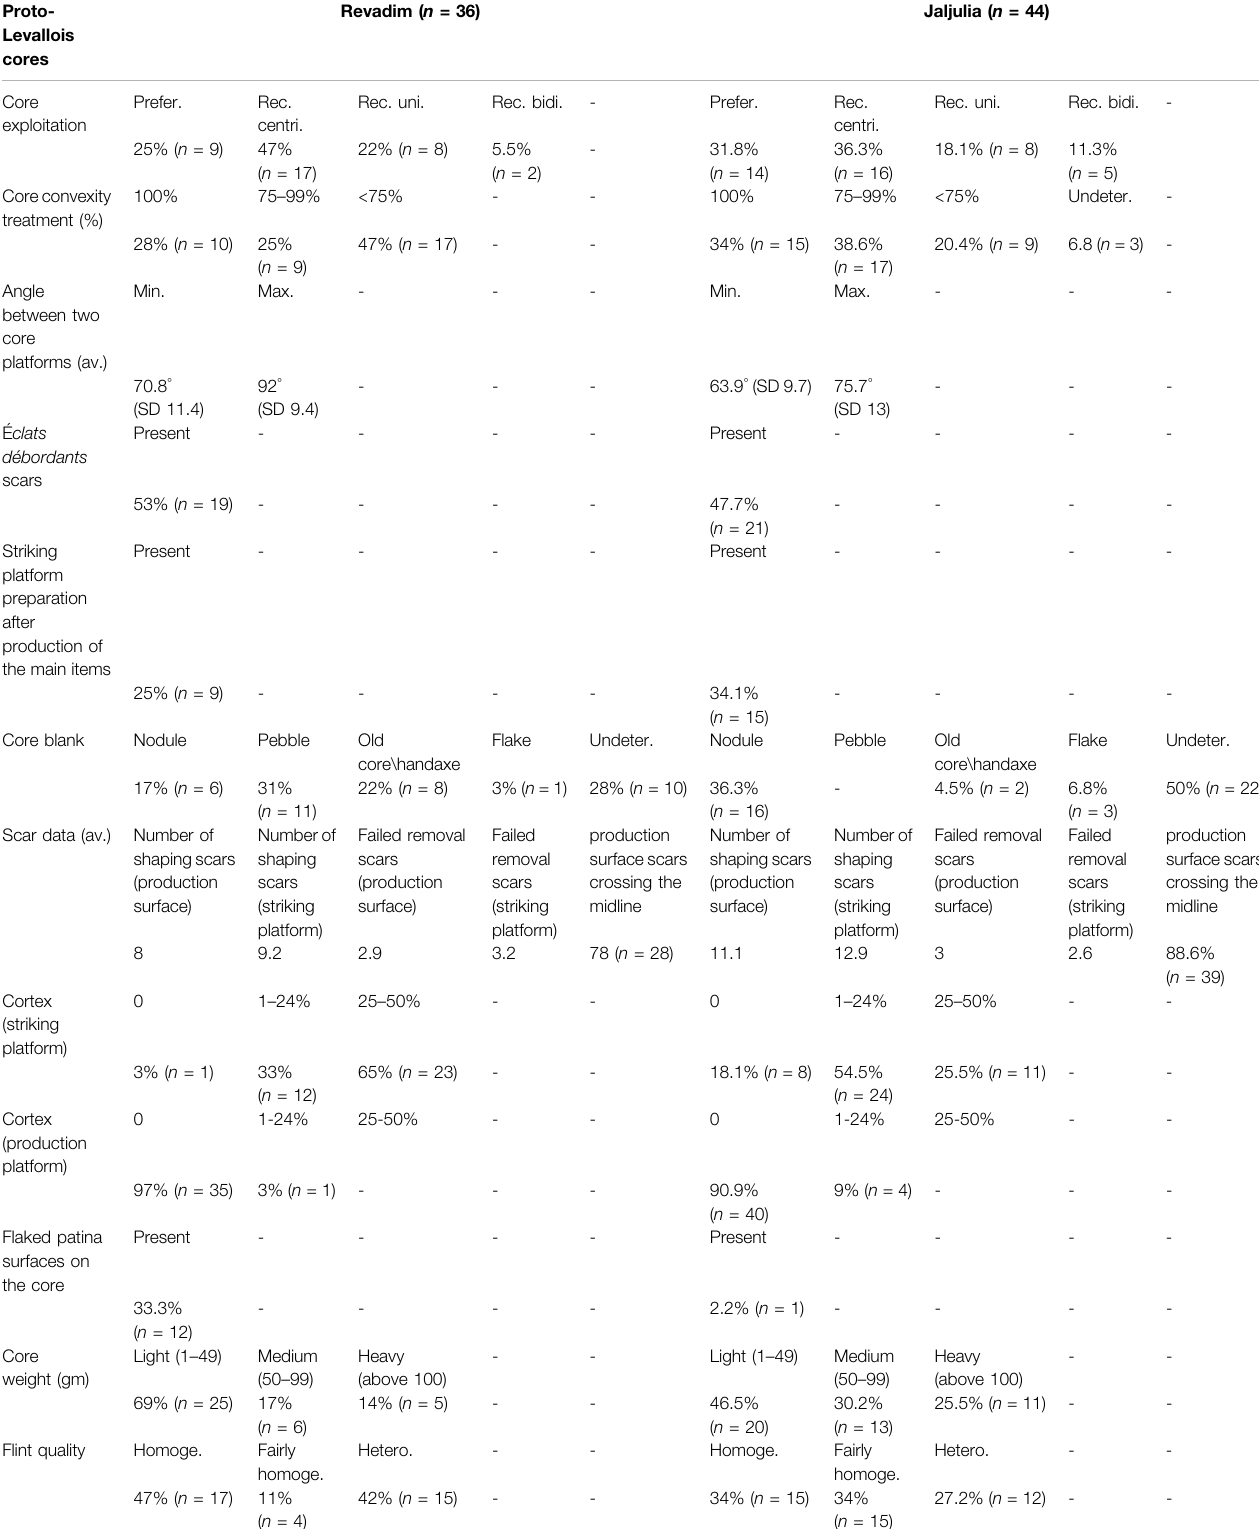
TABLE 1 | Major attributes of proto-Levallois cores from both sites. Prefer. (Preferential); Rec. (Recurrent); centri. (centripetal); uni. (unidirectional); bidi. (bidirectional) Homoge. (Homogeneous); Hetero. (Heterogeneous) Undeter. (Undetermined). Proto- Revadim ( n = 36) Levallois cores Core Prefer. Rec. exploitation centri.